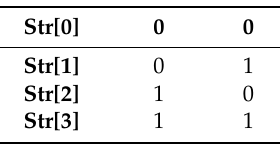
Table 5. The code storage of reader-side ( m =